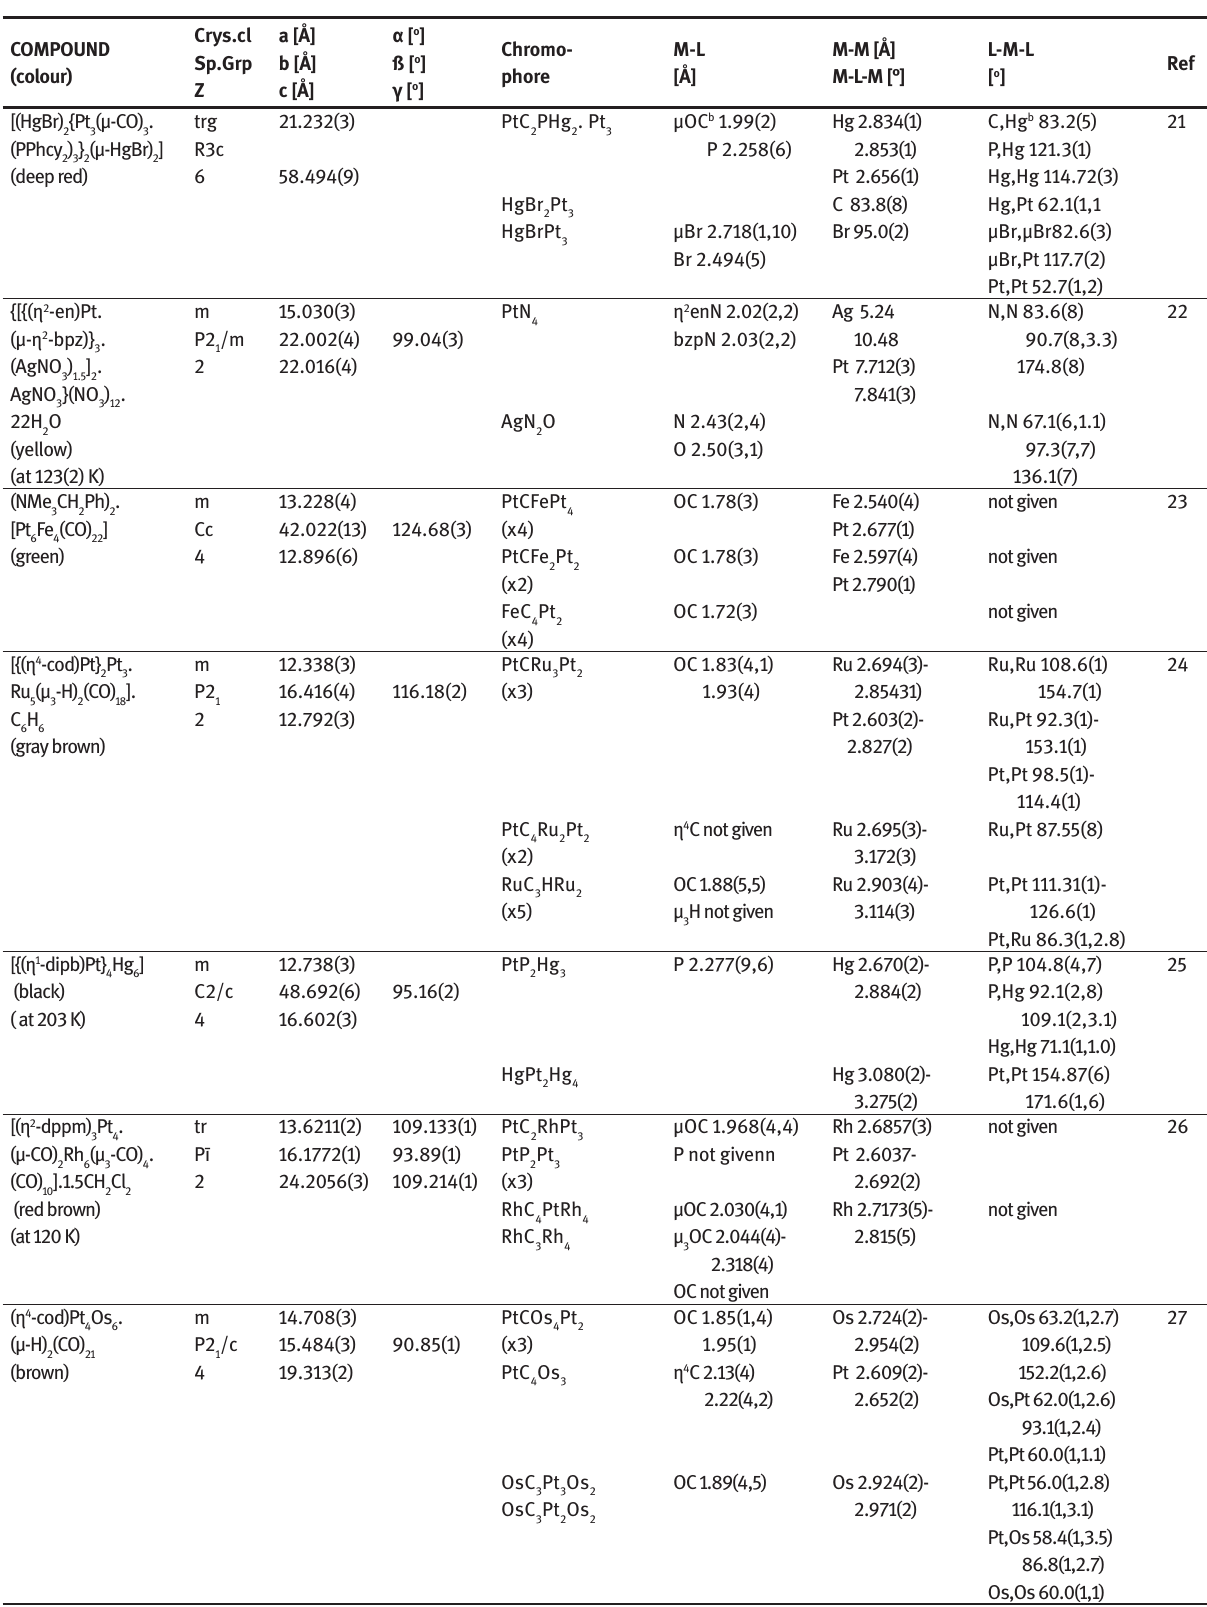
Table 3: Crystallographic and structural data for heterodecanuclear platinum clusters a .